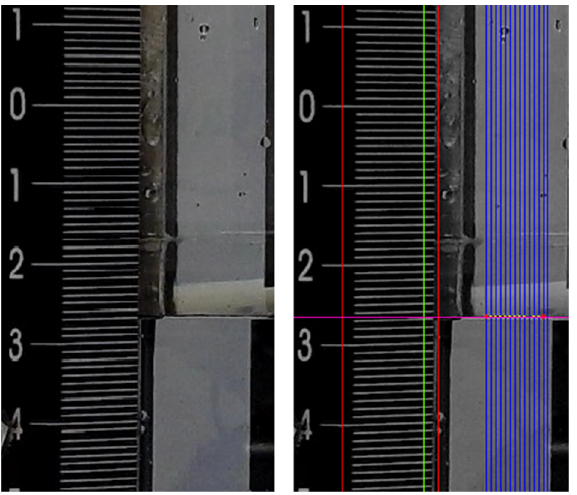
Figure 8. Measuring scale and liquid level; raw image (left) and processed image with marked detection area/lines (right). detection area/lines